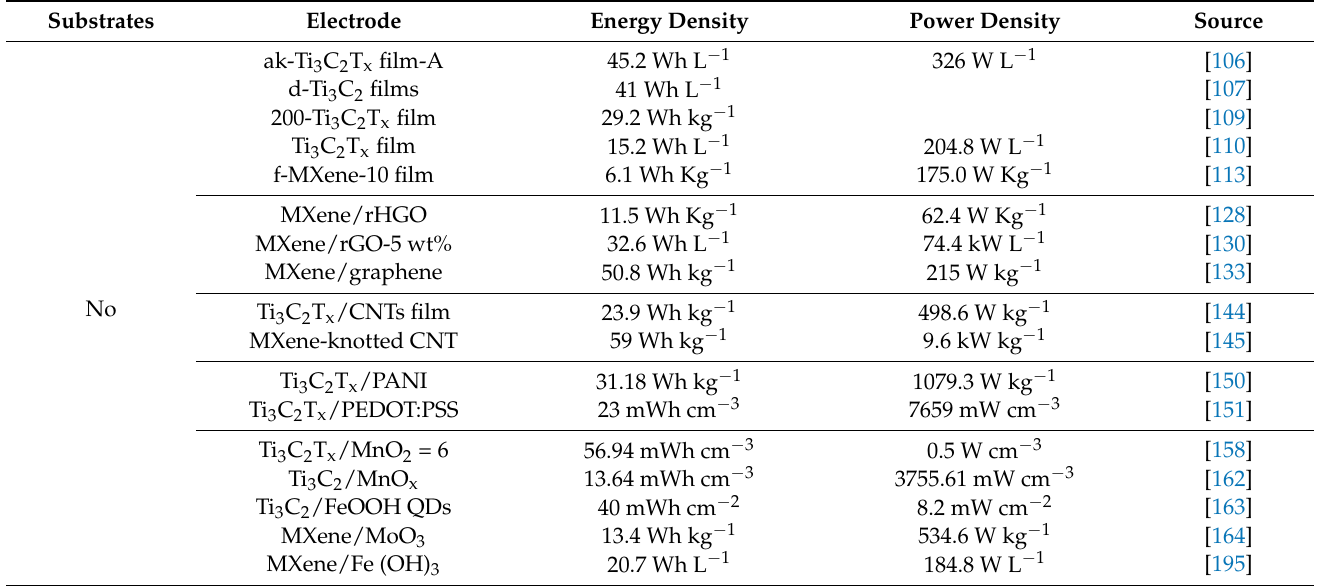
Table 3. Comparison of the energy density and power density of MXene-based flexible